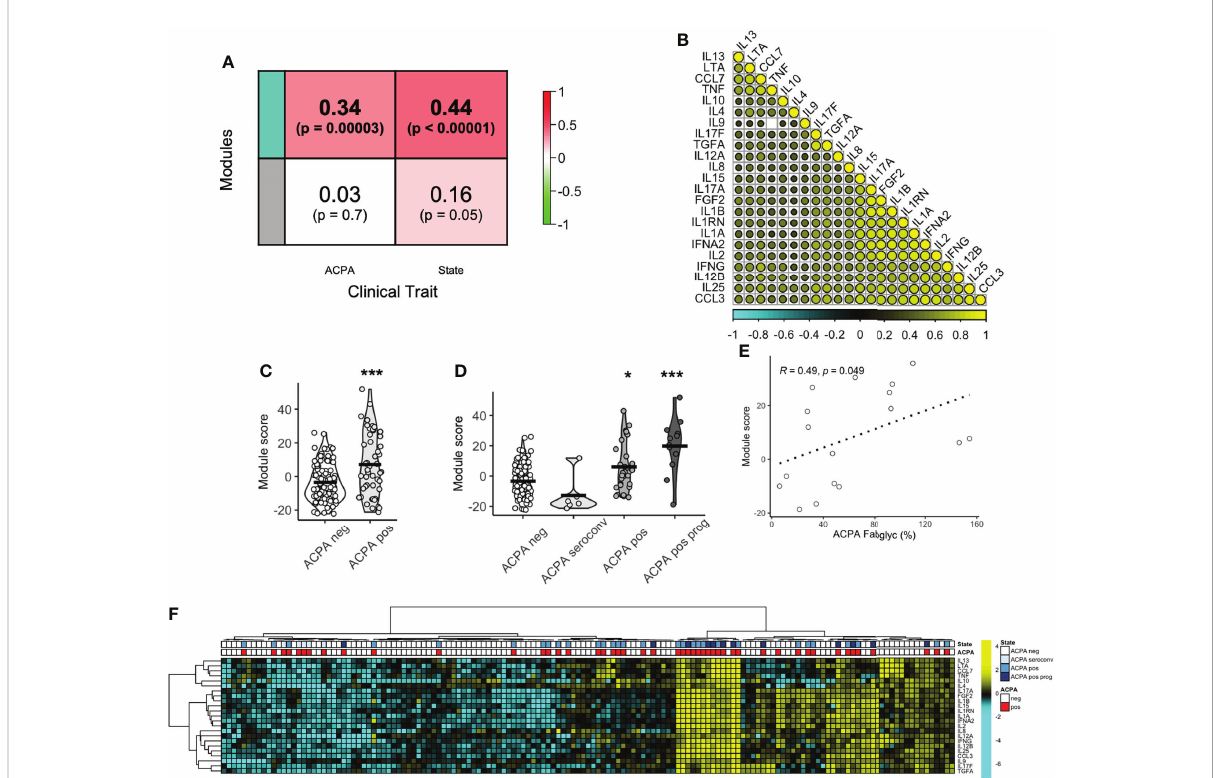
FIGURE 3 Protein co-expression network enriched in ACPA positive FDR. (A) Correlation coef fi cient between protein co-expression modules (Teal, Grey) and ACPA or longitudinal outcome (state), colored based on strength of association. (B) Correlation matrix of protein module members (Teal) colored based on strength of correlation (range -1 to 1). (C) Box plots of module score comparing ACPA positive and ACPA negative groups. Analyzed by t-test, *** p < 0.001. (D) Violin plots of module score based on longitudinal outcomes, ACPA negative, ACPA seroconversion, ACPA positive and ACPA positive progression (prog). Analyzed by Dunn ’ s test adjusted by holm. ***p < 0.001, *p < 0.05. (E) Spearman correlation plot of module score and ACPA Fab glycosylation. (F) Heatmap of co-expression network protein members ordered by hierarchical clustering and colored by ACPA status and longitudinal outcomes. ACPA, anti-citrullinated protein antibodies; Fab, variable domain region of